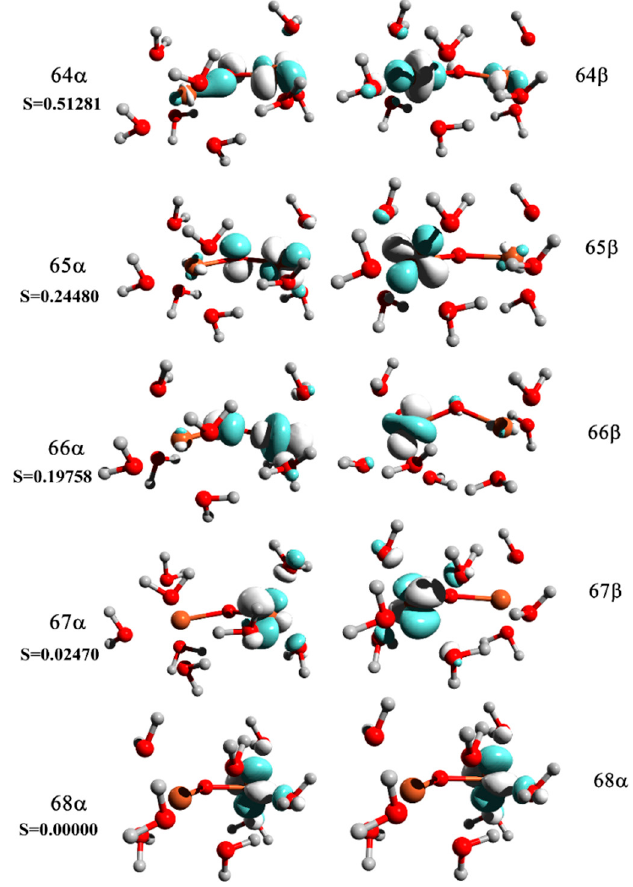
Figure 7. Corresponding magnetic orbitals and spatial overlap integrals, S.